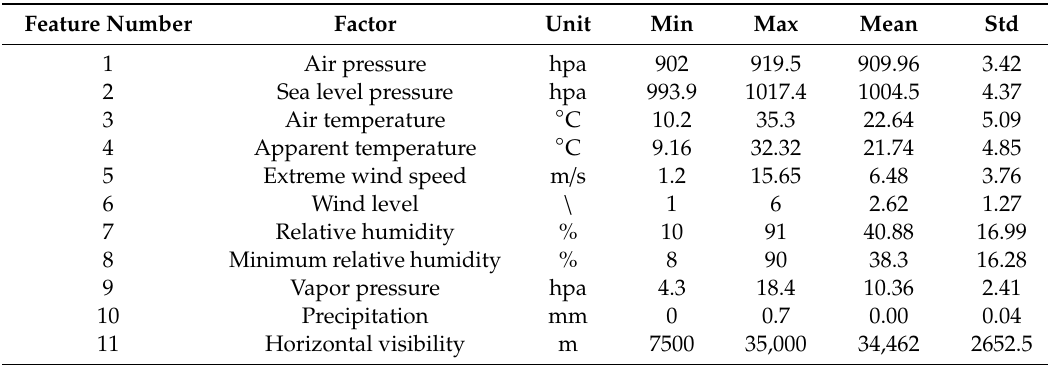
Table 1. Basic information of meteorological